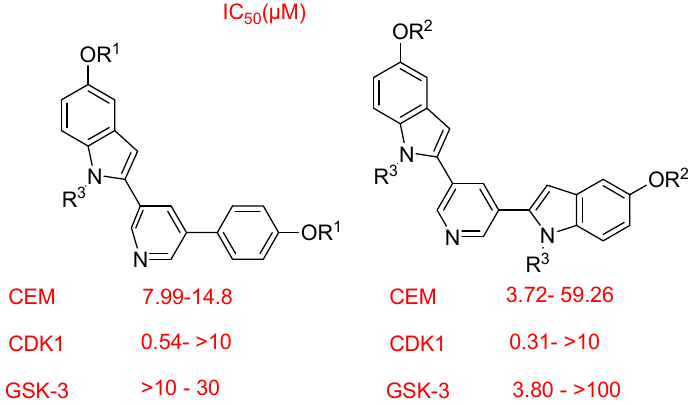
Figure 33. Mono- and bis-indole-pyridine